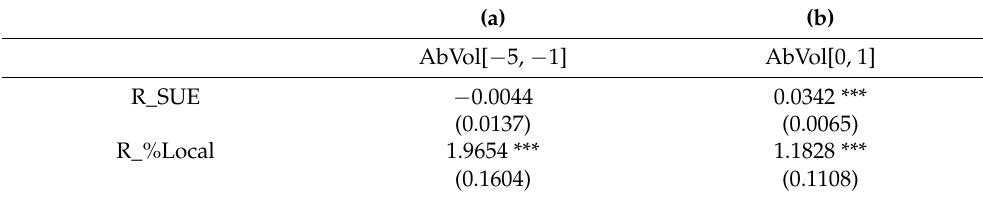
Table 9. Second-Stage Regression Results of Abnormal Trading